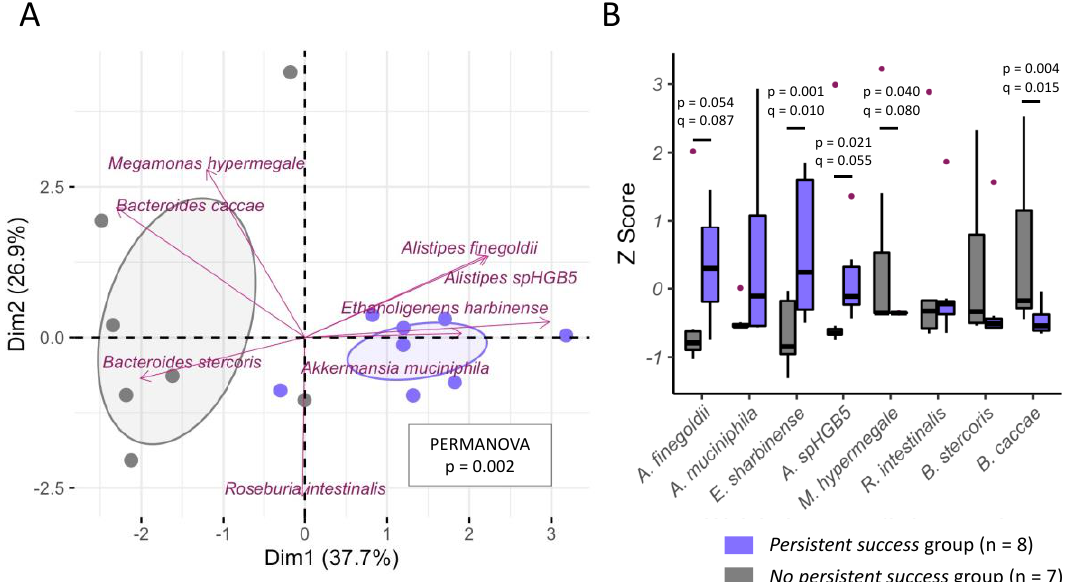
Figure 2. Microbial differences between individuals from the persistent success and the nonpersistent success groups on species level. ( A ) This principal component analysis plot shows the 8 weight-loss predictive species as well as the 15 individuals, color-coded by their persistent/nonpersistent weight-loss status. Distances between the dots (representing individuals) were computed by the Euclidean index on centered-log ratio transformed data of the eight weight-loss predictive species shown in Table 5. Dim, dimension/principal component; PERMANOVA, permutational multivari- ate analysis of variance. ( B ) Boxplots showing the comparisons of bacterial abundance (Z score) between the two groups for each species using Mann – Whitney U tests with the respective p -values being adjusted with the false discovery rate method (q-value). Only comparisons with q < 0.1 are shown.